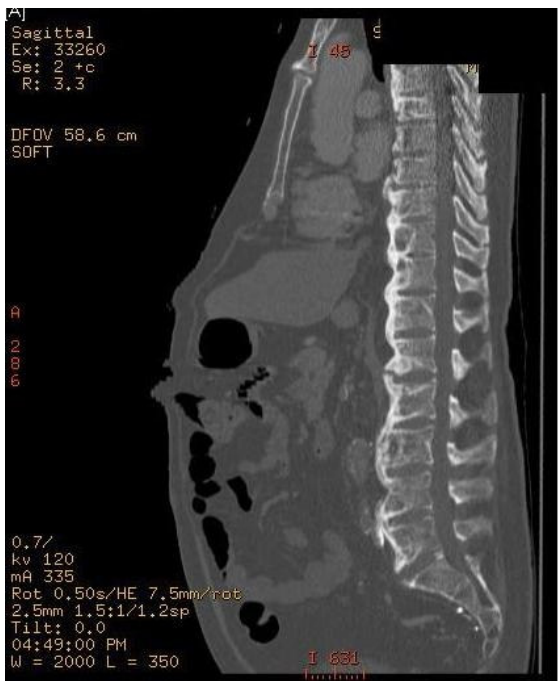
FIGURE 3. CT of abdomen (sagittal reconstruction) shows normal alignment of lumbar spine with no evidence of collapse of body of vertebra or